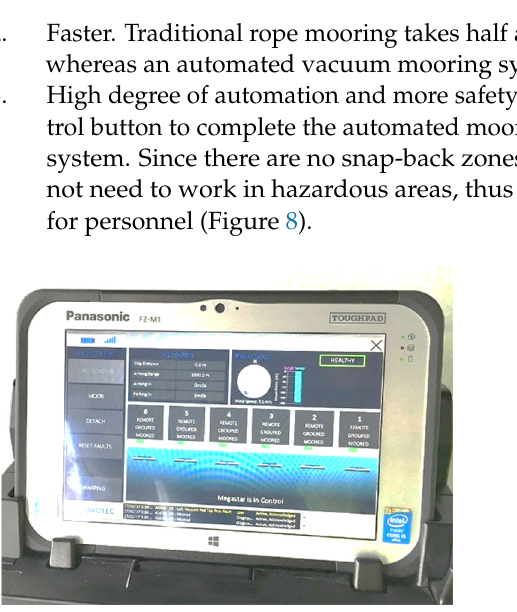
Figure 8. Operation